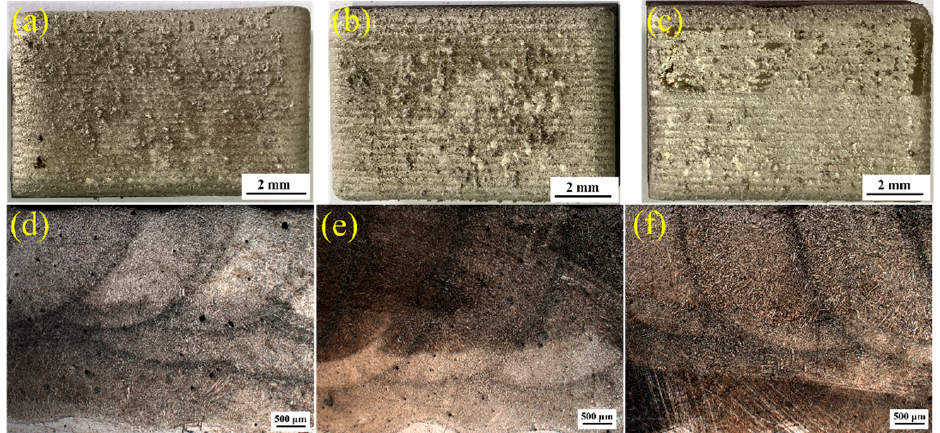
Figure 2. Macroscopic morphologies of three cladding coatings ( a , d ) sample LC1; ( b , e ) sample LC2; ( c , f ) sample LC3. Table 2. Different parameters of laser cladding.